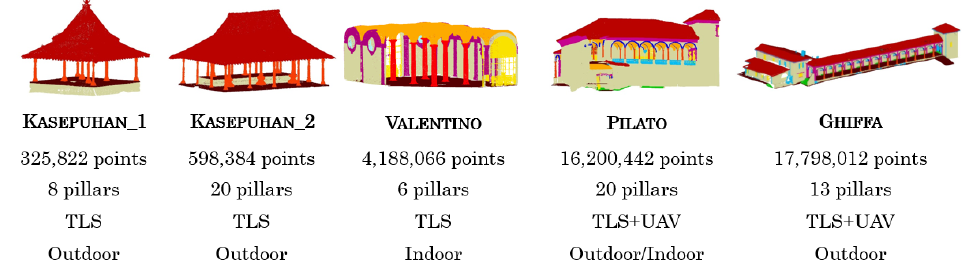
Figure 1. The point clouds used for the experiments' section, with basic metadata as retrieved from the ArCH website. The number of pillars corresponds to free-standing pillars, i.e. does not include engaged columns.